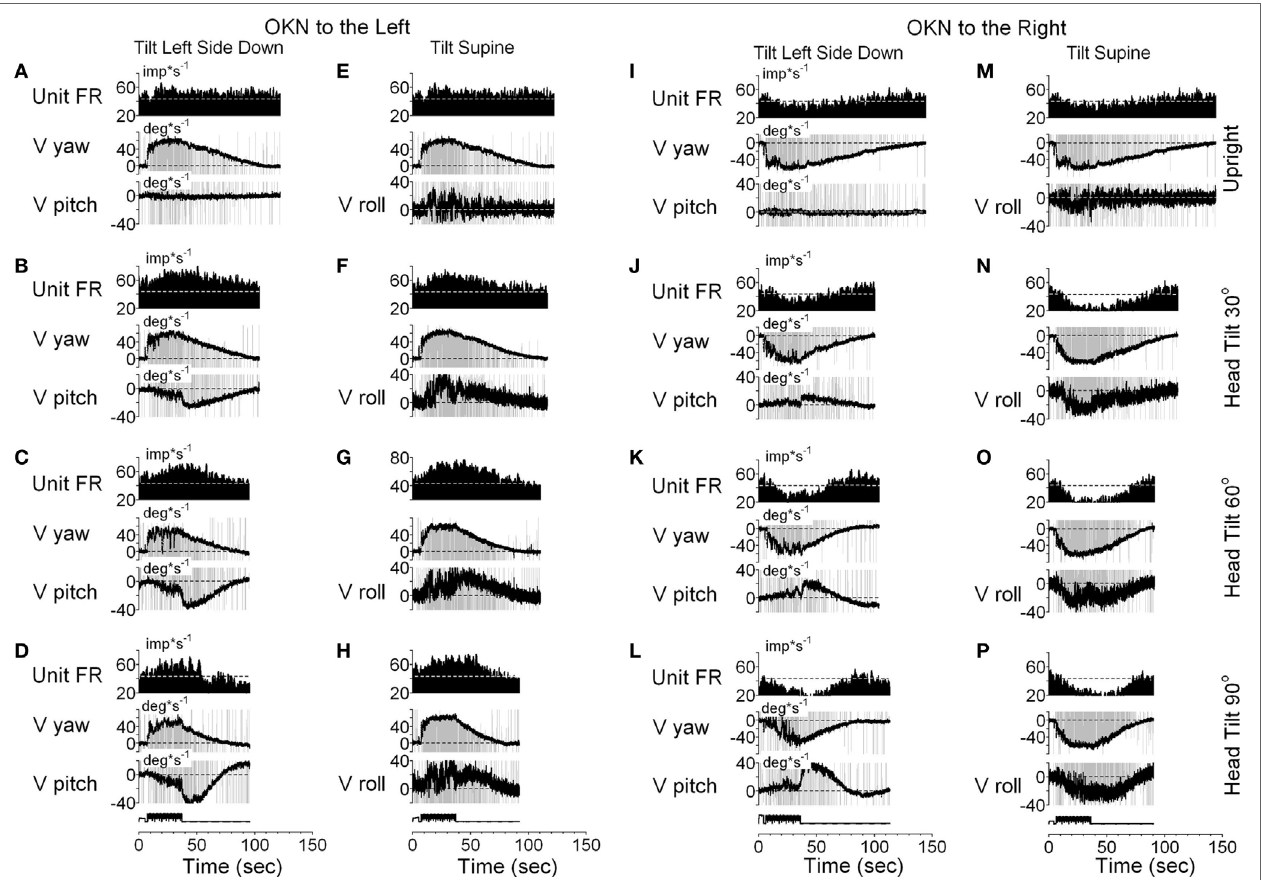
FigUre 11 | Unit firing rates and yaw (V yaw), pitch (V pitch), and roll (V pitch) slow phase eye velocities for a VPS neuron that received input from the ipsilateral anterior canal during optokinetic nystagmus (OKN)/optokinetic after-nystagmus to the left (a–h) and to the right (i–P) . This neuron was tested in the left side down (a–D,i–l) and supine (e–h,M–P) positions. In each position, the neuron was tested while upright (a,e,i,M) or while tilted 30° (B,F,J,n) , 60° (c,g,K,O) , or 90° (D,h,l,P) . Data in panel (e) are duplicate of panel (a) , and data in panel (M) are duplicate of panel (i) . This was done to organize data in columns to simplify